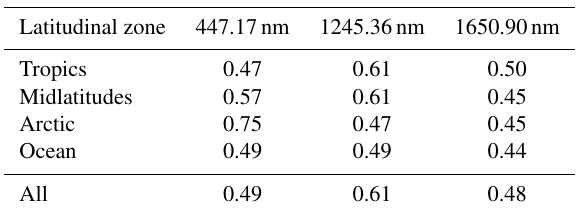
Table 5. Variance in thresholds used to screen clouds based on bootstrapping the threshold calculations described in the initial ex- periment 500 times. The variance is presented as a percentage of the mean of the particular zone. The false-positive setting was α FP = 1000 and the false negative α FN =